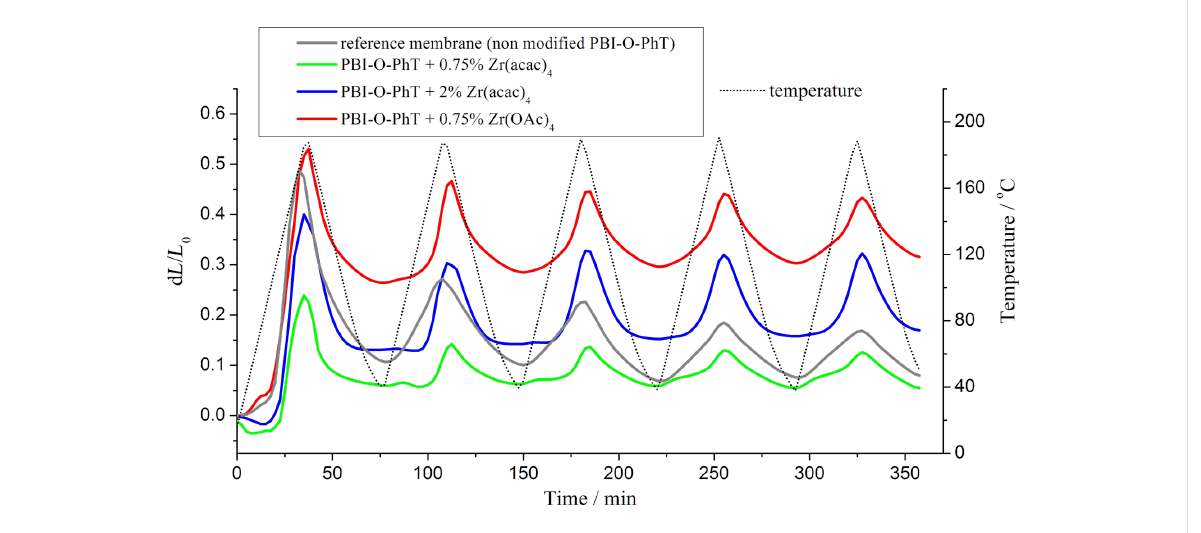
Figure 6: Change of the relative membrane thickness in a series of five consecutive heating/cooling cycles. The temperature change is given by the dotted line.